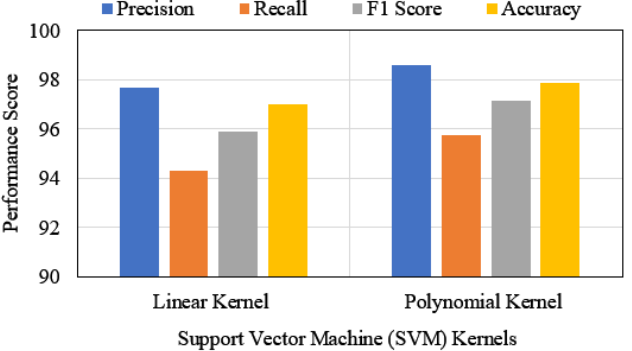
Figure 5. Performance’s comparison of SVM-kernels under